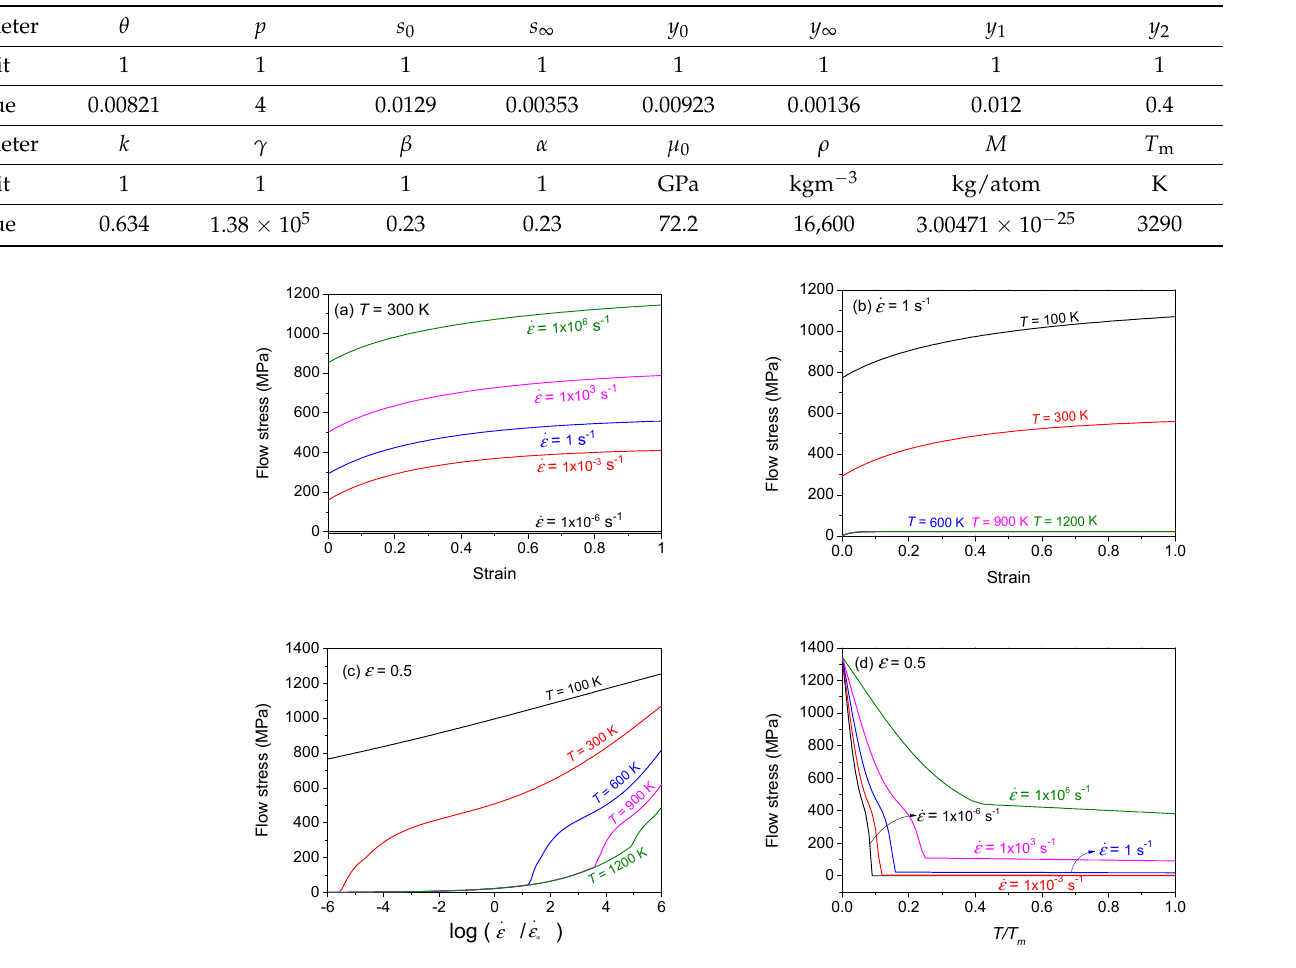
Figure 24. Flow stress–strain curves predicted for tantalum using the PTW model ( a ) at 300 K for different strain rates and ( b ) at 𝜀(cid:4662) = 1 for different temperatures. Change in flow stress at 𝜀 = 0.5 ( c ) with log ( 𝜀(cid:4662) / 𝜀(cid:4662) ∗ ) for different temperatures and ( d ) with T / T m for different strain rates ( 𝜀(cid:4662) ∗ = 1 s − 1 , T m = 3290 K). The temperature dependence of the stress–strain curve at 𝜀(cid:4662) = 1 s − 1 is shown in Figure 24b. While the curves can be obtained at least up to 1200 K, no apparent difference exists among curves at above approximately 600 K, which is unrealistic. The coupling of strain hardening with temperature (change in curve shape with temperature) is not apparent.